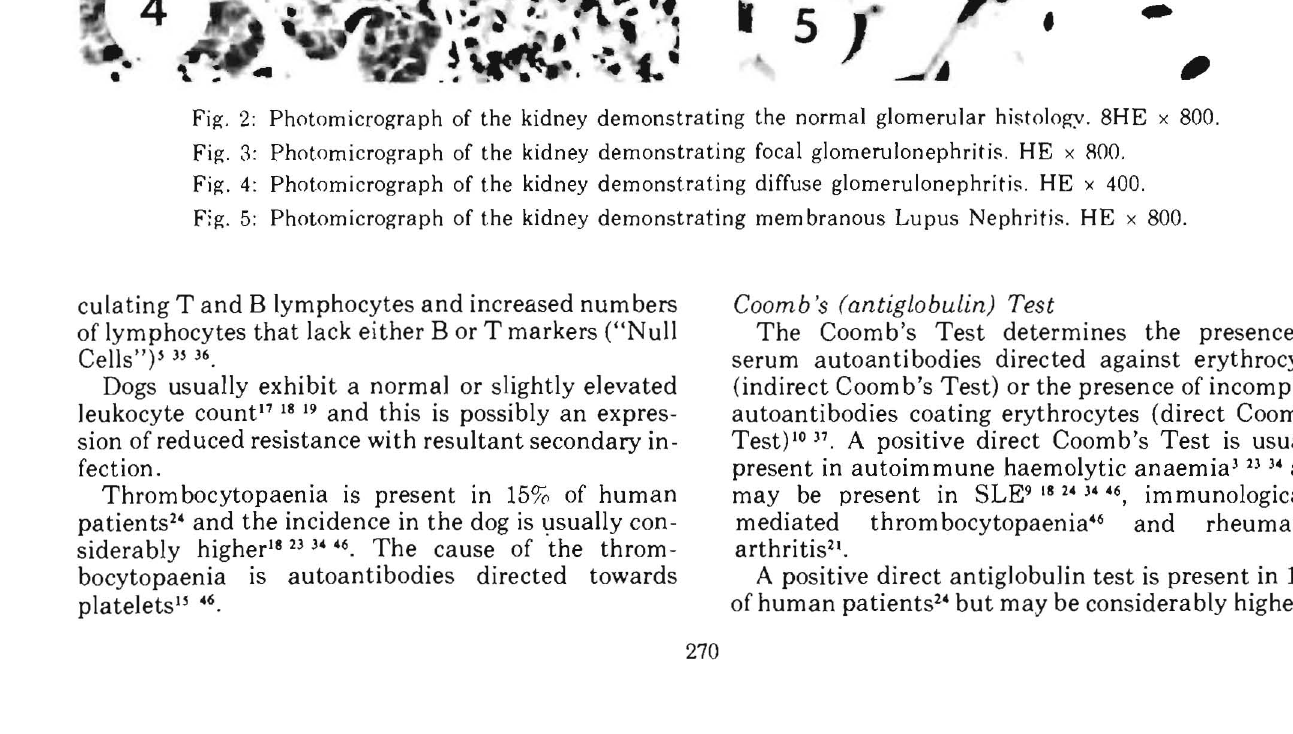
Fig. 2: Photomicrograph of the kidney demonstrating the normal glomerular hi~tology. 8HE x 800. Fig. 3: Photomicrograph of the kidney demonstrating focal glomerulonephriti~. HE x ROO. Fig. 4: Photomicrograph of the kidney demonstrating diffuse glomerulonephriti~. HE x 400. Fig. 5: Photomicrograph of the kidney demonstrating mem branous Lupus Nephriti~. HE x 800.